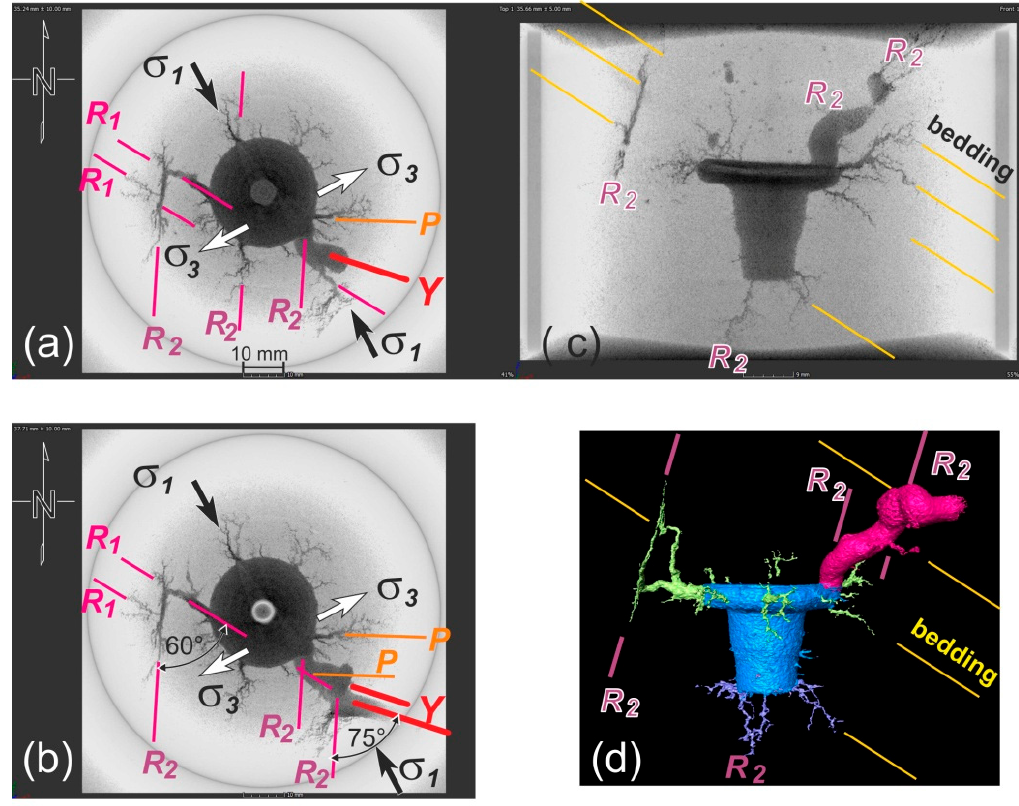
Figure 11. Results of structural interpretation of the dissolution network/wormhole morphology for experiment #7 (10 days of CO 2 -rich solution injection into the sample drilled with inclination imitating injection well): ( a ) Horizontal CT scans showing progressive development of the principal wormhole from the level closed to the injection point ( b ) to the level closed to the top of cylindrical sample, ( c ) vertical CT scan in the E–W direction, and ( d ) 3D model showing the principal wormhole in pink.